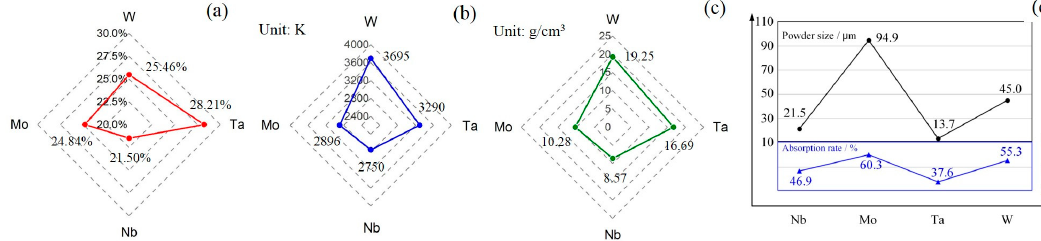
Figure 5. ( a ) Composition distribution results (mean value). ( b ) Melting point of Nb, Mo, Ta, W. ( c ) Liquid density of Nb, Mo, Ta, W. ( d ) Average particle size of four powders and laser absorptivity.